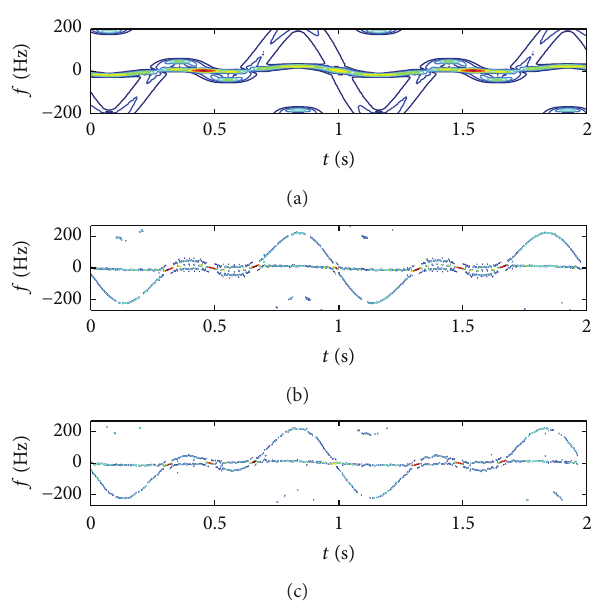
Figure 6: Micro-Doppler time-frequency spectrum: ambigu- ous time-frequency spectrum via STFT (a); unambiguous time- frequency spectrum of adding-perturbation fixed-PRF via CS (b); unambiguous time-frequency spectrum of adding-perturbation sparse-PRF via CS (c).